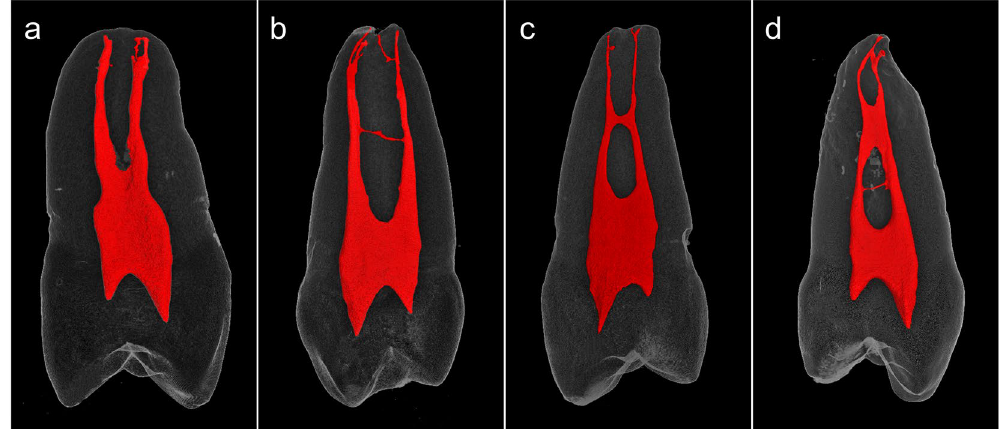
Figure 1. Representative micro-computed tomography reconstructions of single-rooted maxillary premolars containing double root canals. ( a ) Two separate canals. ( b ) Two separate canals connected by a lateral anastomosis in the mid-root. ( c ) Two separate canals connected by a larger anastomosis in the mid-root. ( d ) Two separate canals connected by a sheet-like isthmus in the middle-third and a narrow anastomosis in the coronal-third of the